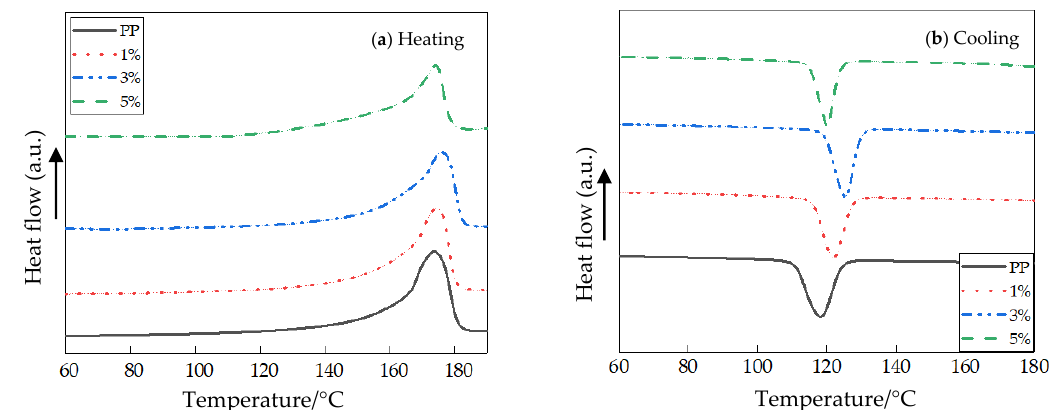
Figure 3. DSC heating and cooling process curves of different samples: ( a ) Heating process curve; ( b ) Cooling process curve.